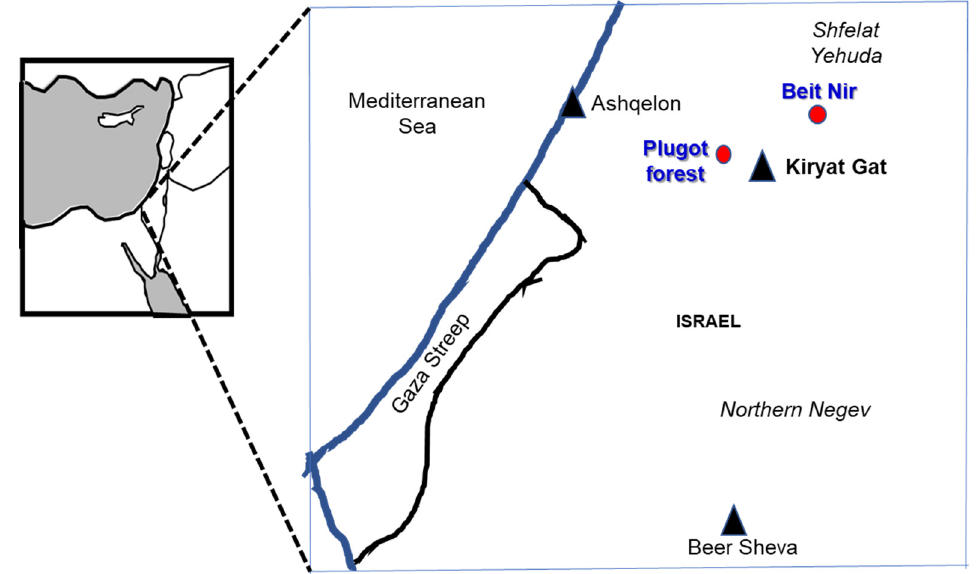
Figure 2. Schematic map of the research sites in the northern Negev and the Shefelat